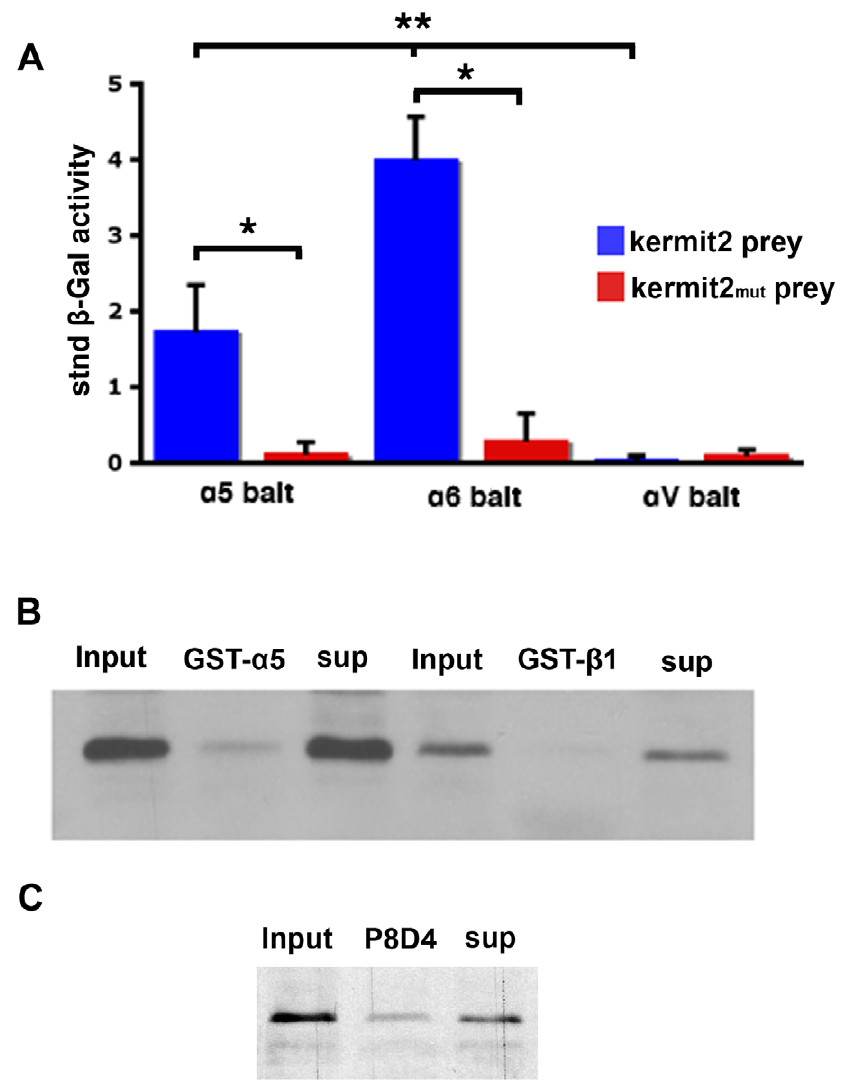
Figure 1. Kermit2 interacts with the cytoplasmic domain of the a 5 and a 6 integrin subunits. (A) Yeast two two-hybrid assays were conducted using a 5, a 6 and a V cytoplasmic domains as bait in combination with kermit2 or kermit2 mut as prey. The data is presented as average normalized b -galactosidase activity ( 6 SD). The interaction of kermit2 with a 5 and a 6 is abolished by the AEEL mutation in kermit2 mut (* P , 0.002). The a V subunit does not interact with kermit2 or kermit2 mut (** indicates P , 0.001 between a 5 or a 6 and a V bait constructs). (B) GST pulldowns. HA tagged Kermit2 is detected in lysates (lane 1 input), and is pulled down with a GST- a 5 fusion construct (lane 2 GST- a 5). Most of the kermit2 remains in the supernatant (lane 3 sup). A control GST- b 1 construct (lane 5 GST- b 1) does not pull Kermit2 from lysates (lane 4 input, lane 6 sup).